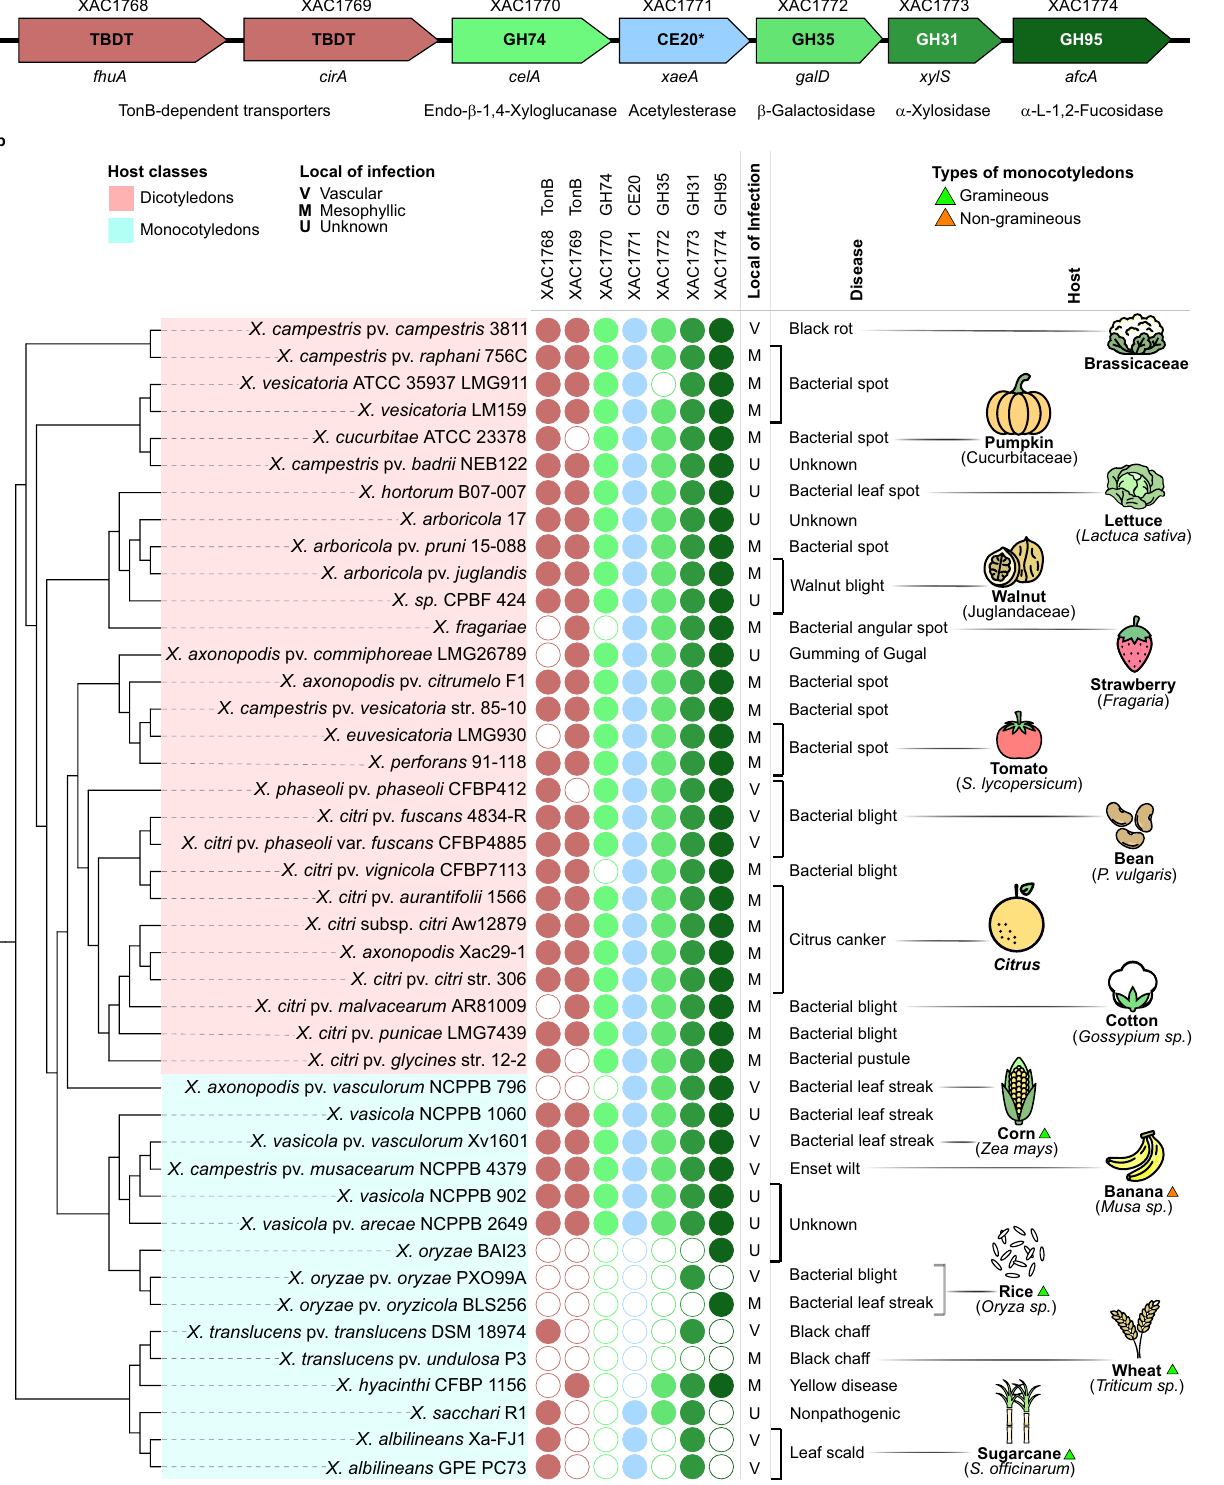
Fig. 1 The XyGUL conservation in Xanthomonas spp. a XyGUL predicted in X. citri pv. citri 306 genome showing TonB-dependent transporters (TBDT in pink), glycoside hydrolases (GHs in shades of green) and a carbohydrate esterase (CE in blue, * revealed in this work). b Dendrogram of Xanthomonas species based on phylogenetic analysis (details in Supplementary Fig. 2) showing the presence ( fi lled circles) or absence (open circles) of XyGUL genes and information about disease and tissue/host speci fi city. V = vascular, M = mesophyllic and U = unknown. Some species infect dicotyledons (pink box), whereas others colonize monocotyledons (blue box). Monocotyledons are subdivided in gramineous (green triangle) or non-gramineous (orange